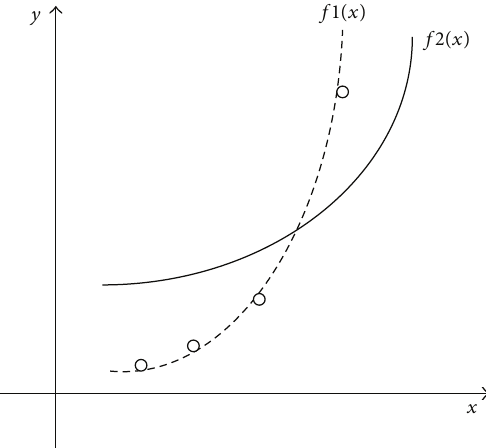
Figure 4: Four data points and two different curves.